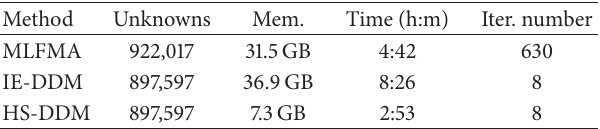
Table 1: Computational statics of antennas on